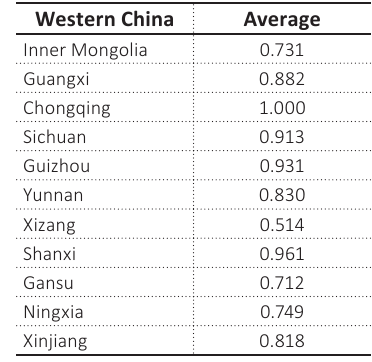
Table 1. Average performance of government funding in higher education of each